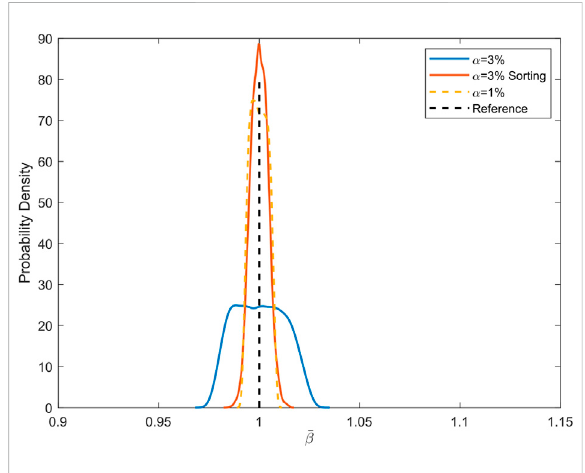
FIGURE 13 PDFs of the indicator with and without sorting strategy when disorder strength is 3%.